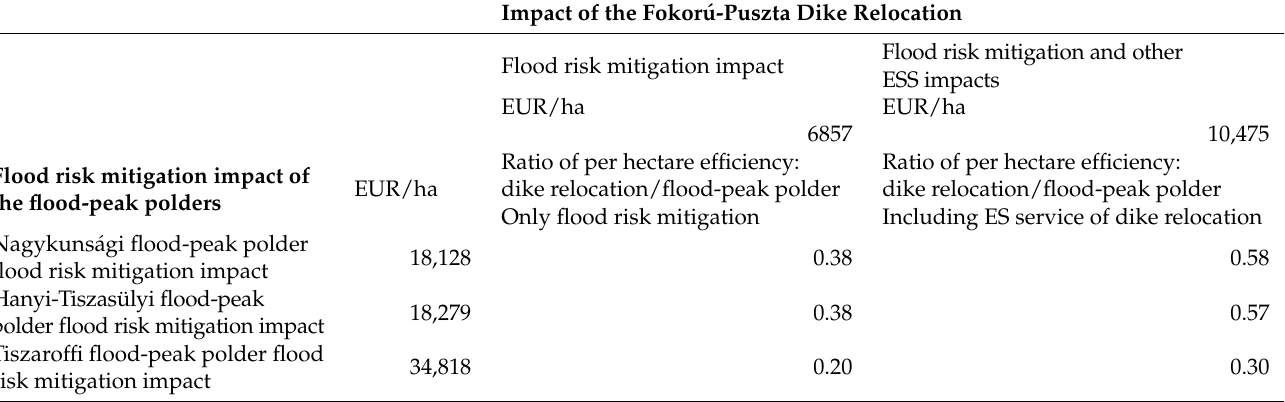
Figure 3. Map of the Fokor ú -puszta dike relocation site. Legend: The map shows the change in the line of the dike and the area incorporated into the floodplain. Source: Ref. [21]. Table 3. Flood-peak polders and dike relocation land service productivity comparison. Legend: Source of data: Refs.